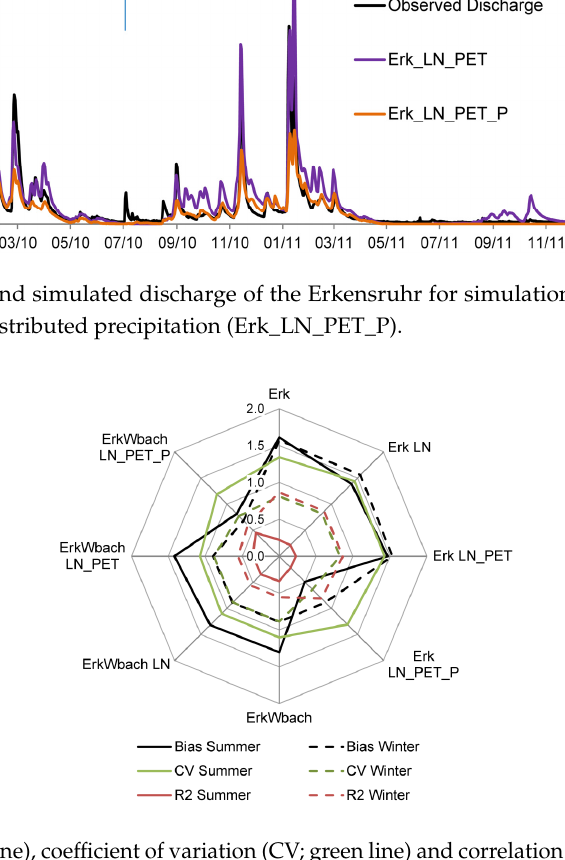
Figure 8. Bias (black line), coefficient of variation (CV; green line) and correlation coefficient (red line) in hydrological summer (solid lines) and winter (dashed lines) for the Erkensruhr discharge simulations.